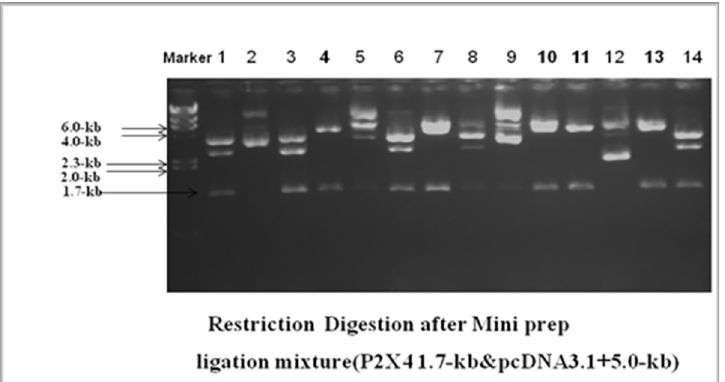
Fig 1. Confirmation of P2X4 gene in vector pcDNA3.1+ Marker: λ HindIII digested marker. Lanes 4, 10, 11, and 13 showing digested plasmid with the release of